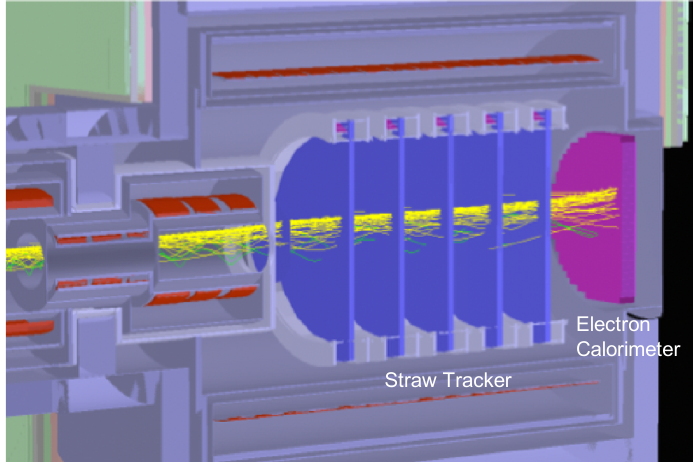
Figure 4. Schematic layout of the StrECAL detector system for the muon beam measurement during Phase-I.